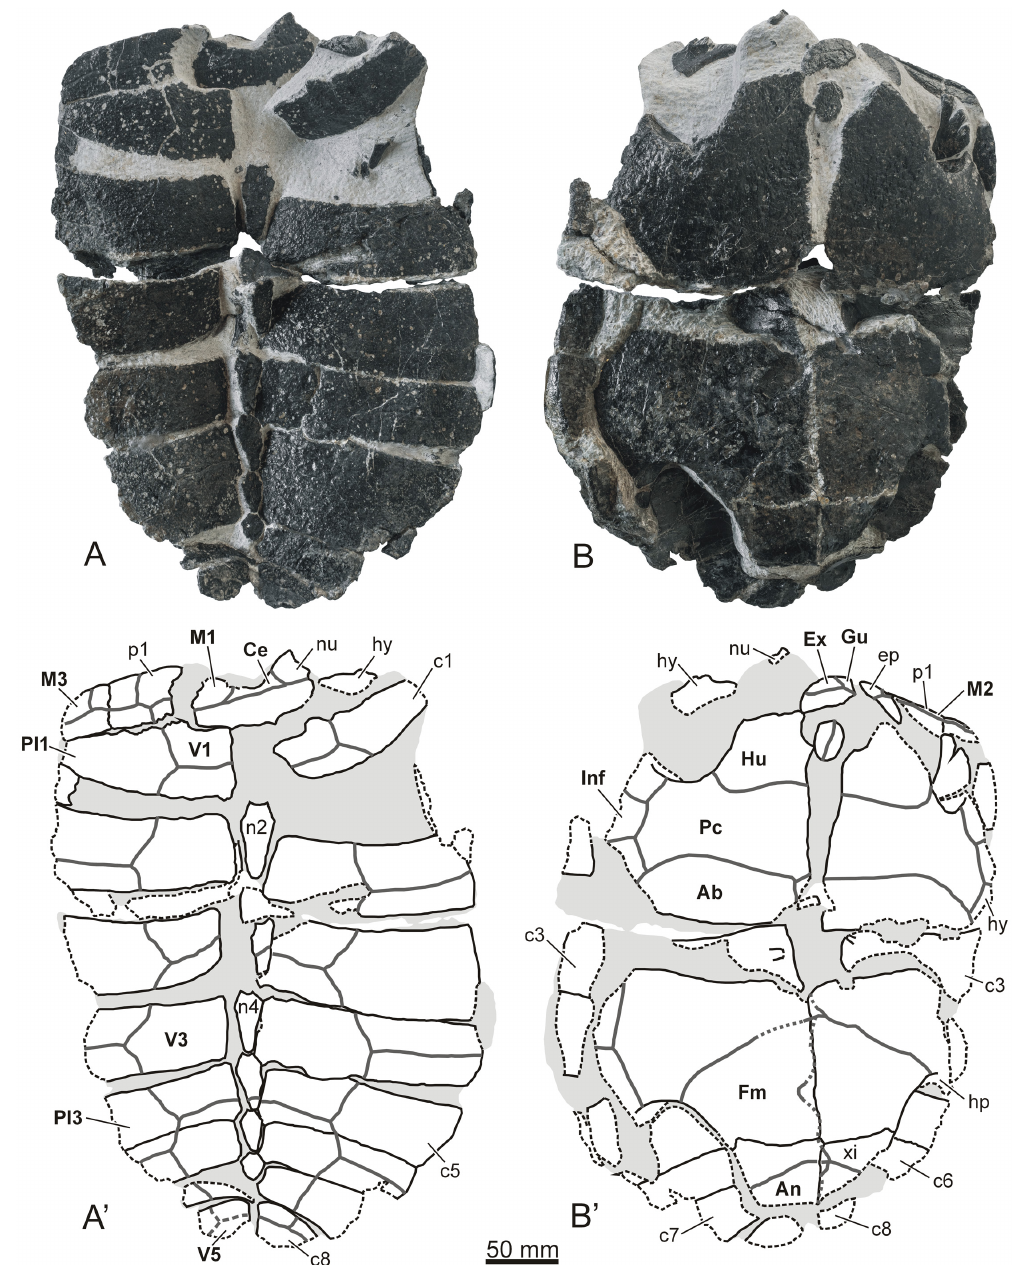
Figure 2. Specimen SHN 025, a partial and articulated shell of the thalassochelydian turtle Hylaeo- chelys kappa from the middle to late Tithonian Freixial Formation of Porto Chão Beach (Cambelas, São Pedro da Cadeira Civil Parish, Torres Vedras Municipality, Lisbon District, Lusitanian Basin, west-central Portugal), in dorsal (A–A’) and ventral (B–B’) views. Dotted lines in A’ and B’ indicate broken edges; continuous black lines correspond to the margins of the plates; and the border of the scutes are represented by thicker gray lines.